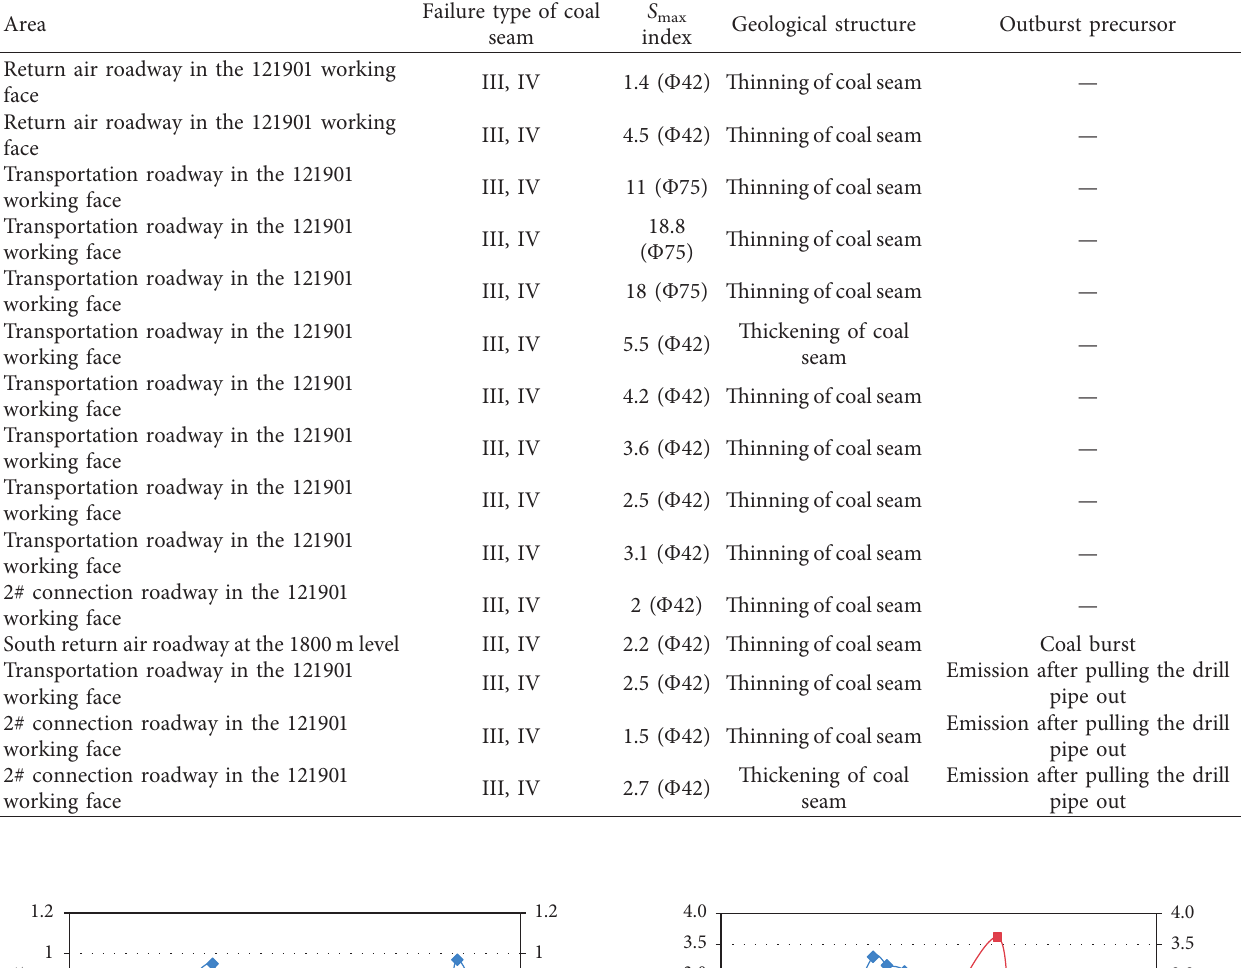
Table 6: Index S of the weight of drilling cuttings based on geological structure and precursor areas of outbursts.